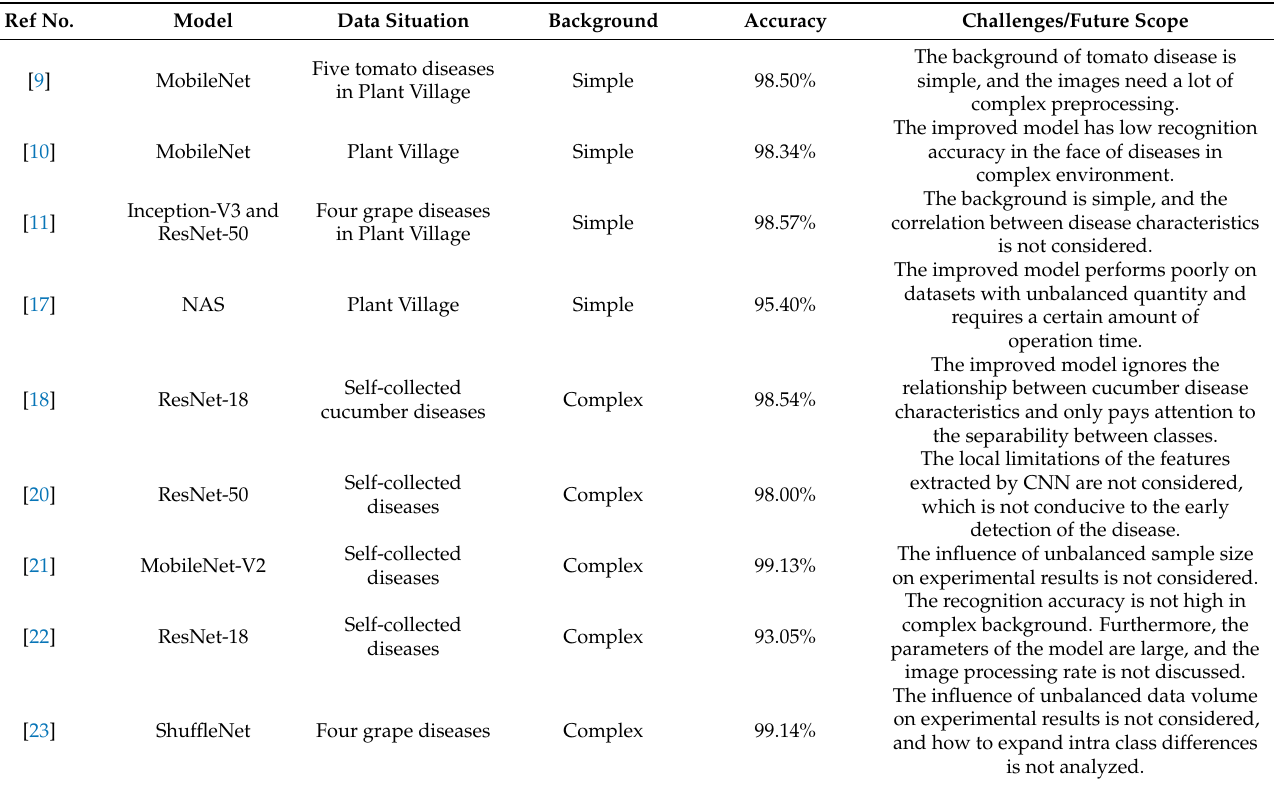
Table 1. Comparative analysis of the related work on plant disease